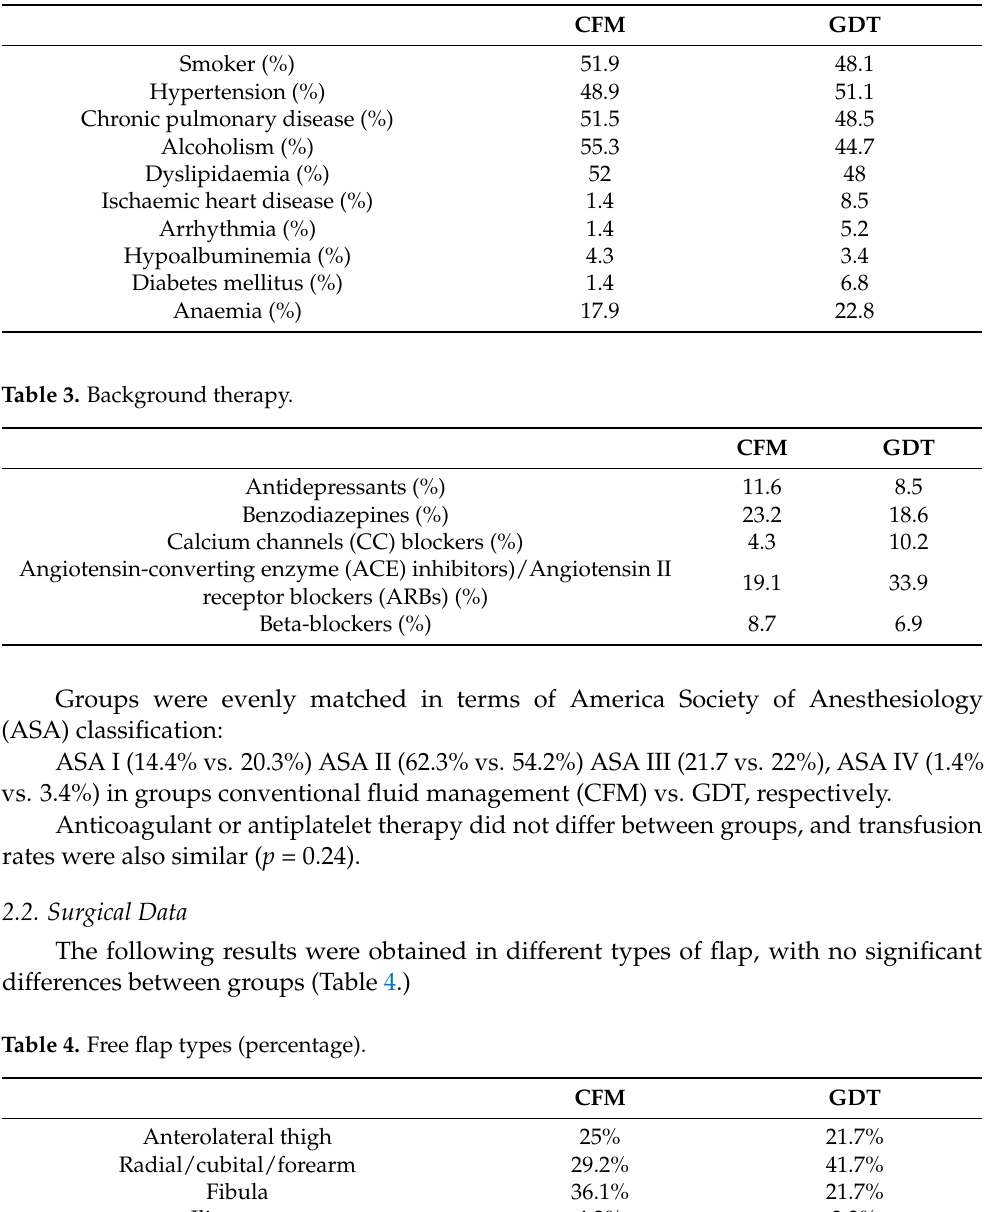
Table 2. Disease history.